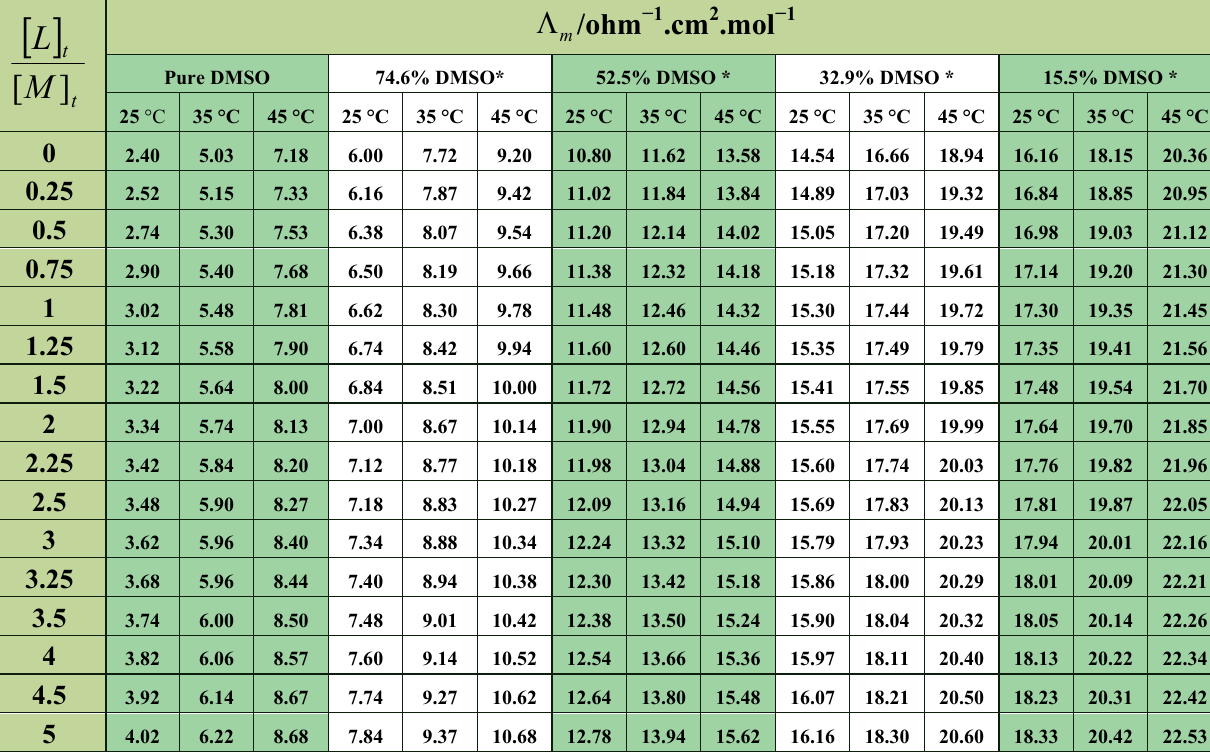
Table 1. Molar conductivity of p -isopropylcalix[6]arene–CsCl system in DMSO-AN binary media at different temperatures.